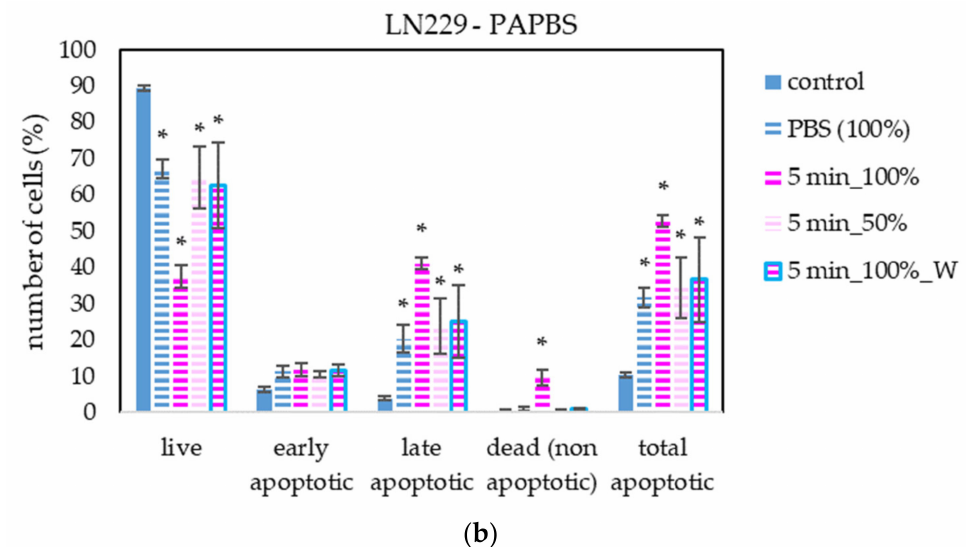
Figure 10. The effect of PAL on apoptosis induction in glioblastoma cells LN229, measured 24 h after PAL application. Plasma-activated medium—PAM ( a ) or plasma-activated PBS—PAPBS ( b ) activated for 5 min in 100% or 50% concentration were used. Time of PAL action was 24 h (without blue frames) or 30 min, after which PAL were replaced with untreated medium (“washing”, W, blue frames). The significant results ( p < 0.05) are marked with *. Significance of 100% PAPBS was tested compared to cells in 100% PBS, significance of other samples was tested compared to control.